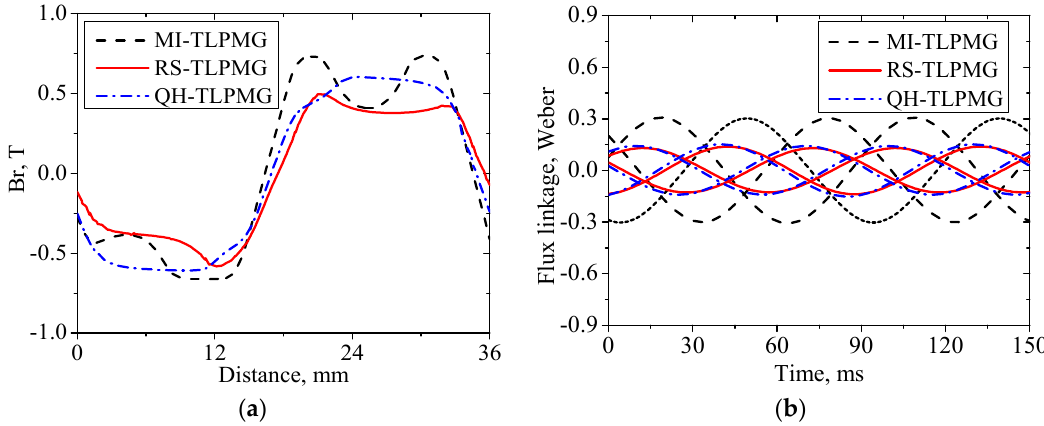
Figure 5. Air gap magnetic flux density and three-phase flux linkage on the no-load condition: ( a ) magnetic flux density; ( b ) three-phase flux linkage.